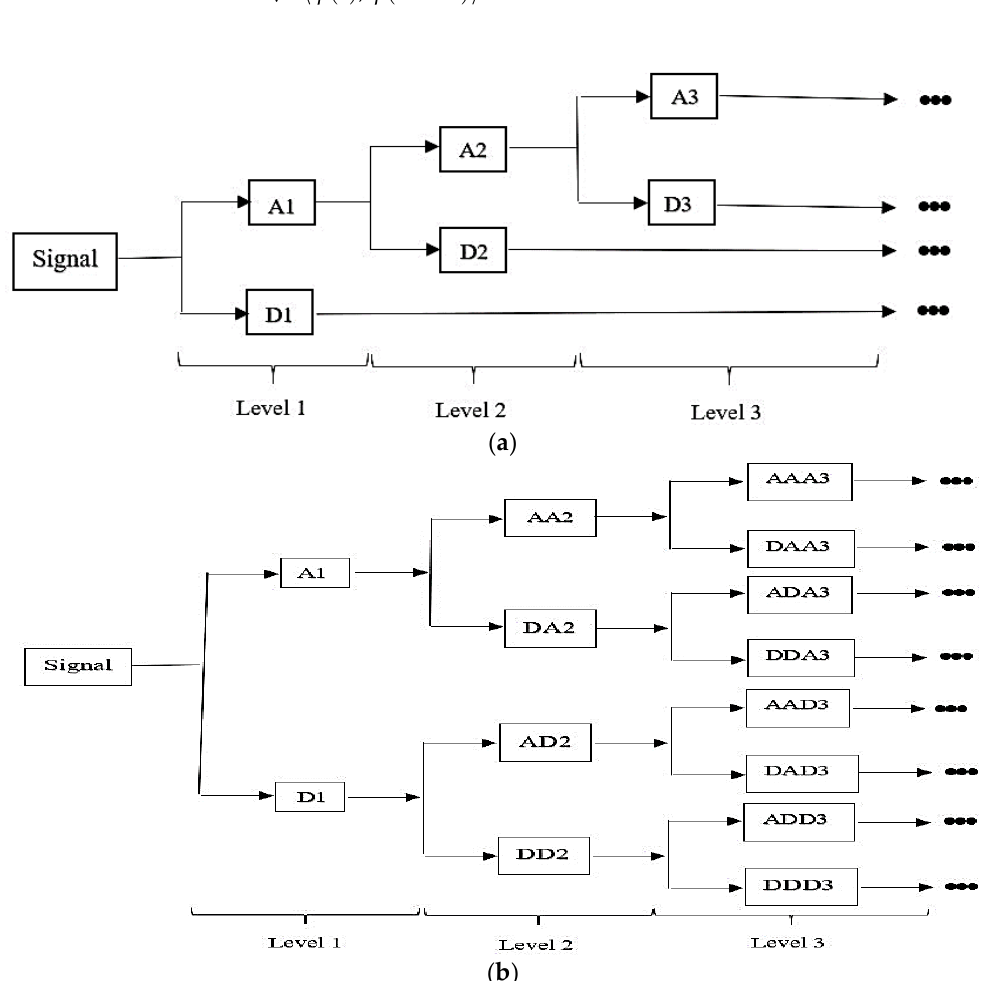
Figure 4. ( a ) Three-level decomposition trees of wavelet transform. ( b ) Three-level decomposition trees of wavelet packet transform.